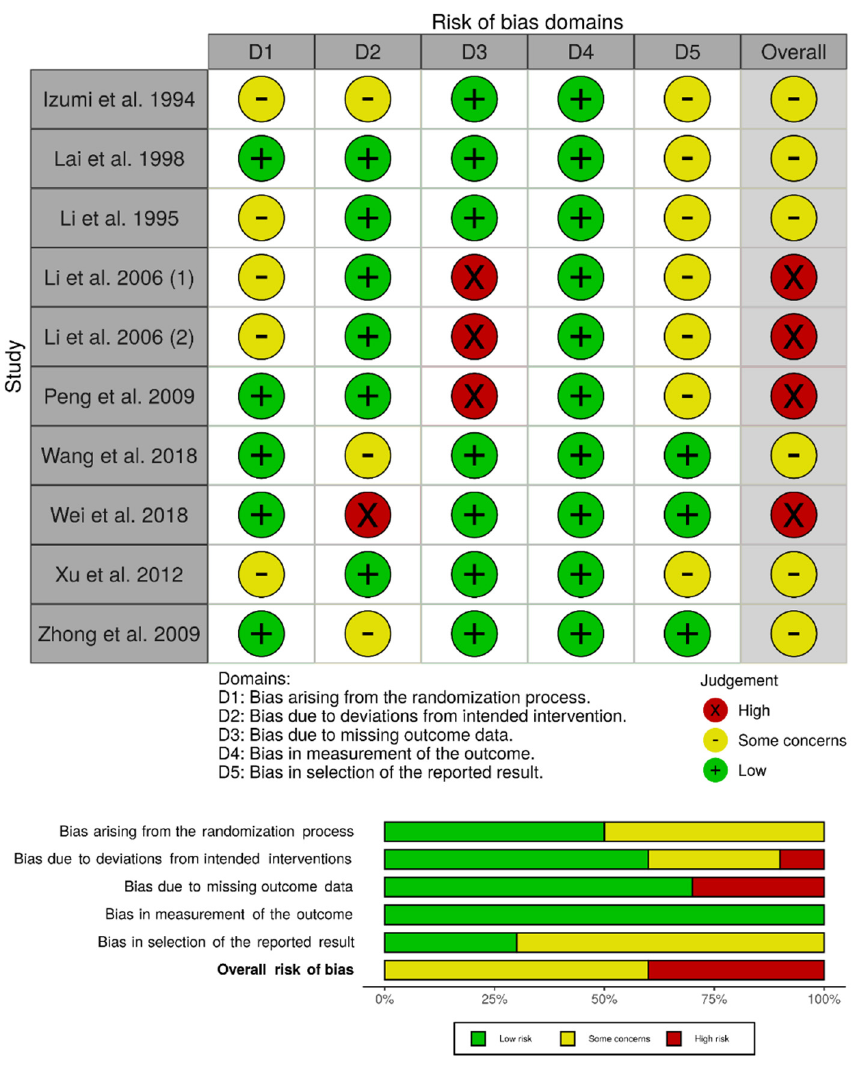
Figure 2. Risk of bias assessment for observational studies using the Risk of Bias 2.0 tool.